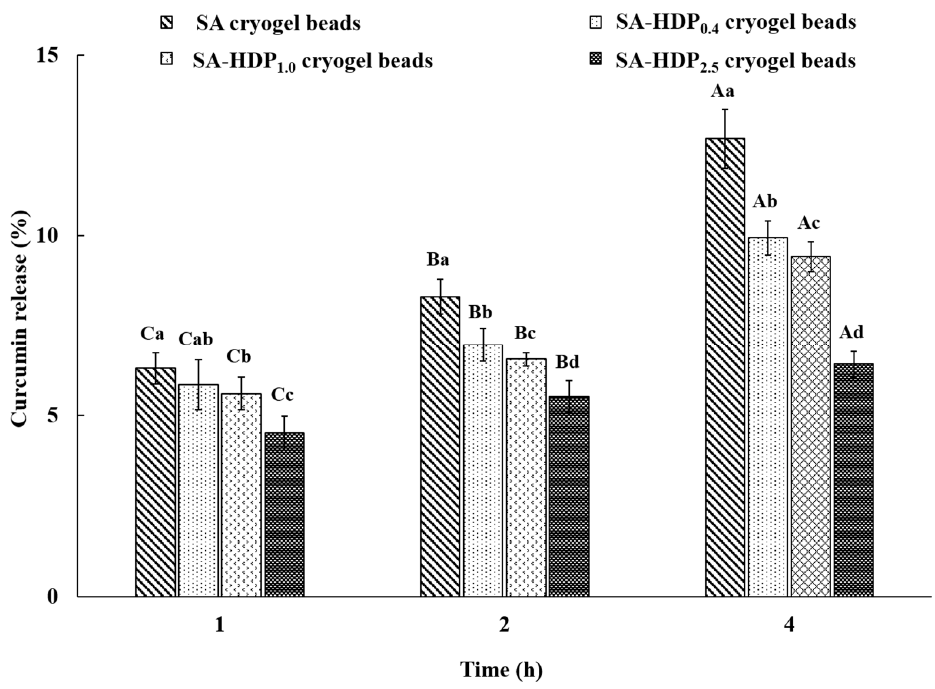
Figure 7. In vitro gastrointestinal tract release properties of sodium alginate (SA)-based cryogel beads filled with different concentrations of hydroxypropyl distarch phosphate (HDP) in simulated intestinal fluid (SIF). SA cryogel beads, SA-HDP 0.4 cryogel beads, SA-HDP 1.0 cryogel beads, and SA-HDP 2.5 cryogel beads represent cryogel beads filled with different concentrations of HDP (0, 0.4, 1.0 and 2.5%, respectively). Small letters show significant differences between treatments at the same time ( p < 0.05), and capital letters show significant differences between times for the same treatment ( p < 0.05).